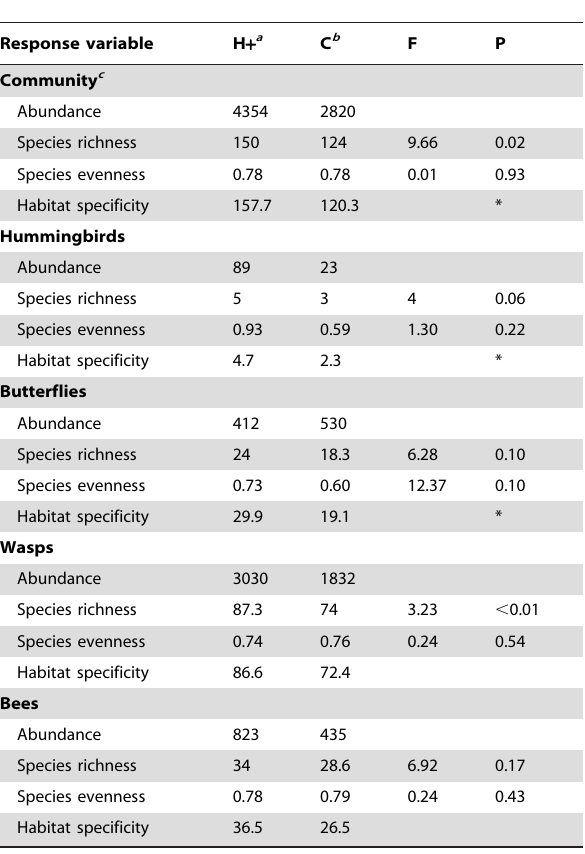
Table 2. Total abundance, mean total species